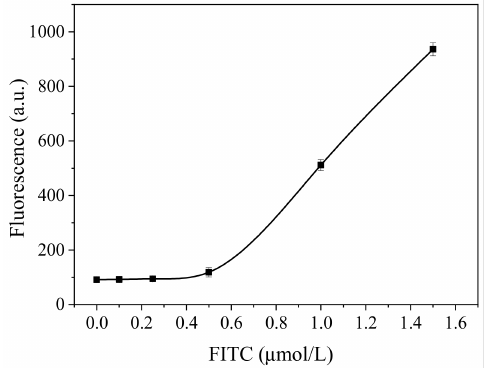
Figure 5. Effect of FITC concentration on Pb 2+ sensing.